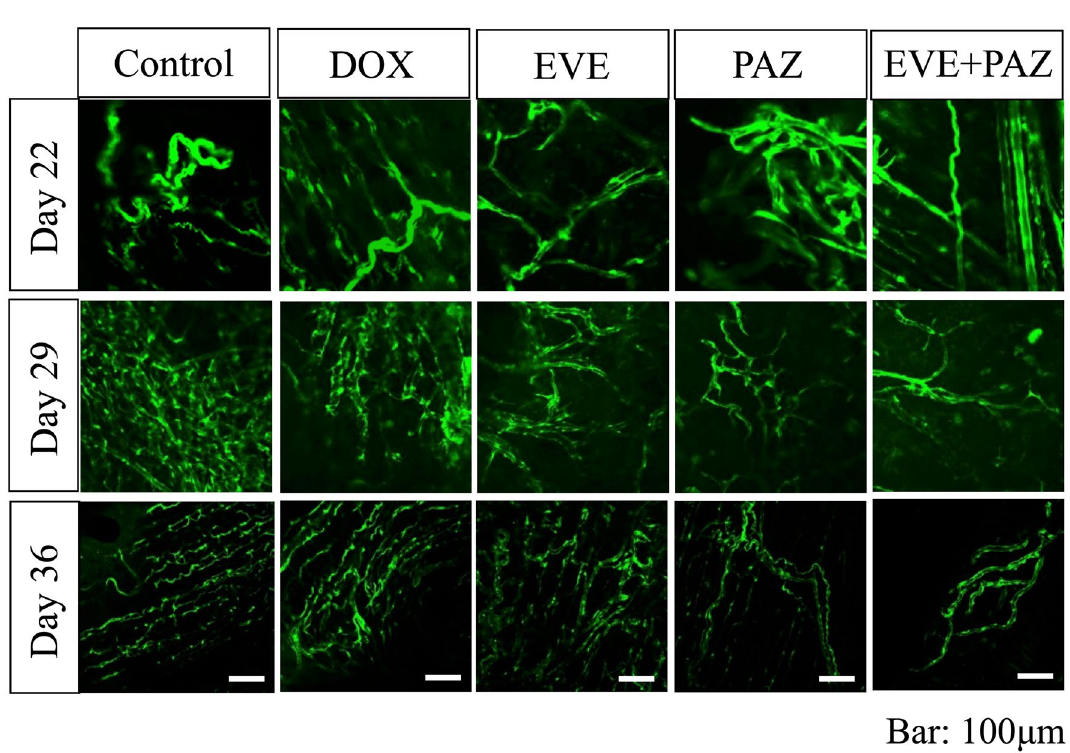
Figure 7. Images of ND-GFP-expressing new vessels in Gelfoam implanted with OS-PDCs in the in vivo Gelfoam angiogenesis assay. Images were obtained with the FV1000 confocal microscope. Scale bars 100